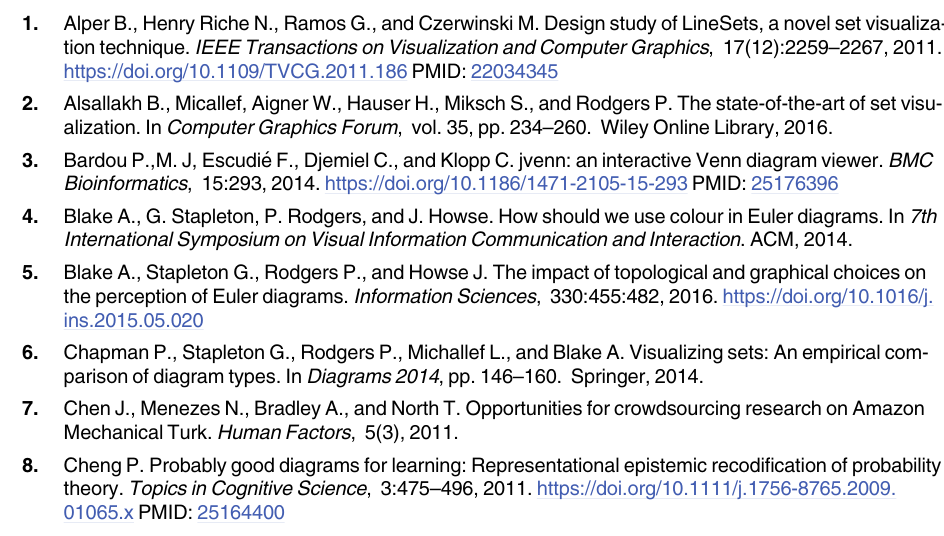
S1 Dataset. Dataset for study one : Euler diagrams. S2 Dataset. Dataset for study two : Linear